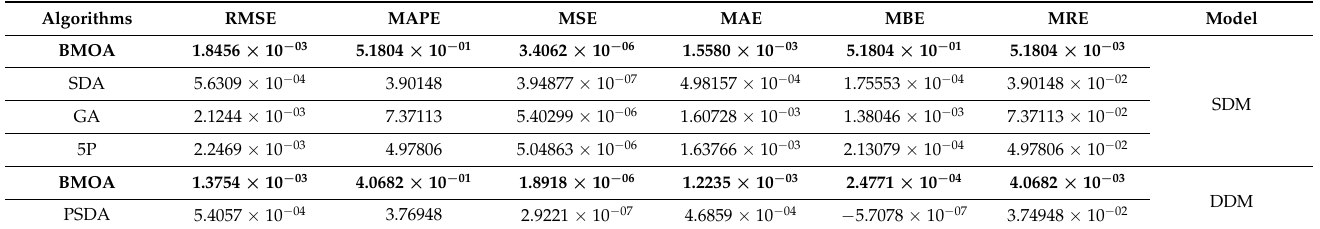
Table 4. Monocrystalline silicon photovoltaic cell (SDM and DDM) statistical